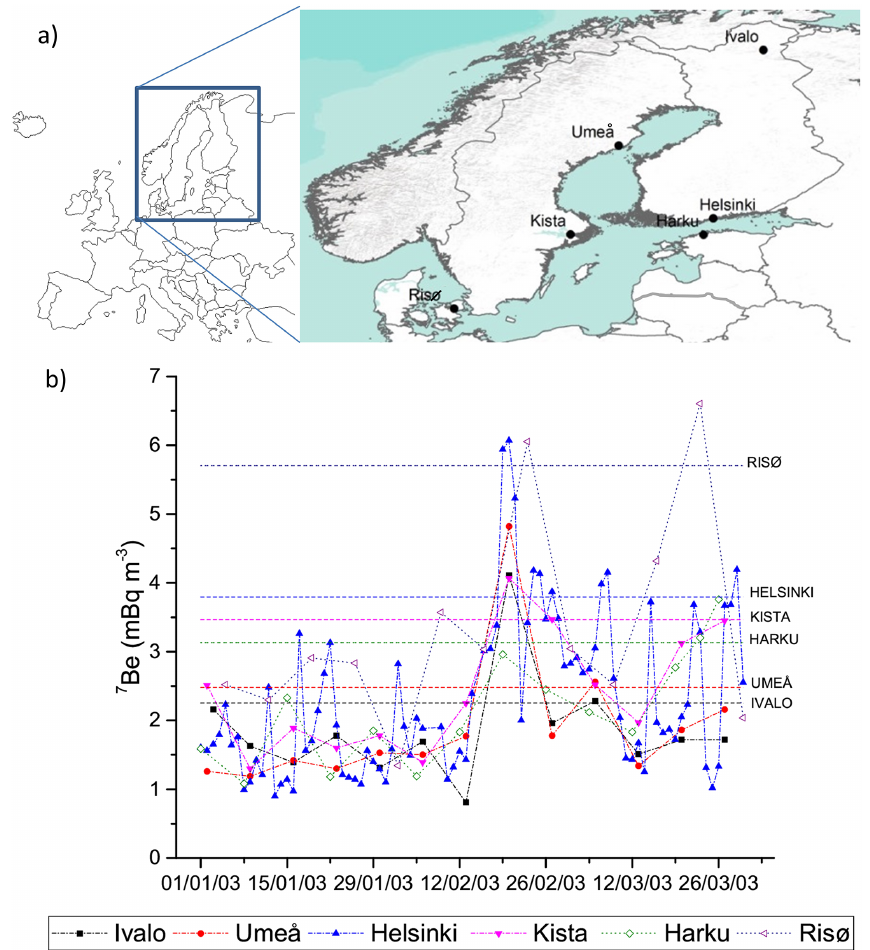
Figure 1. (a) Location of the 7 Be sampling sites in northern Europe (source: https://mapamundiparaimprimir.com/europa/); (b) 7 Be con- centrations measured at six surface sampling sites in northern Europe during the 2002–2003 boreal winter. Dashed lines indicate the 90th percentile reference line for each sampling